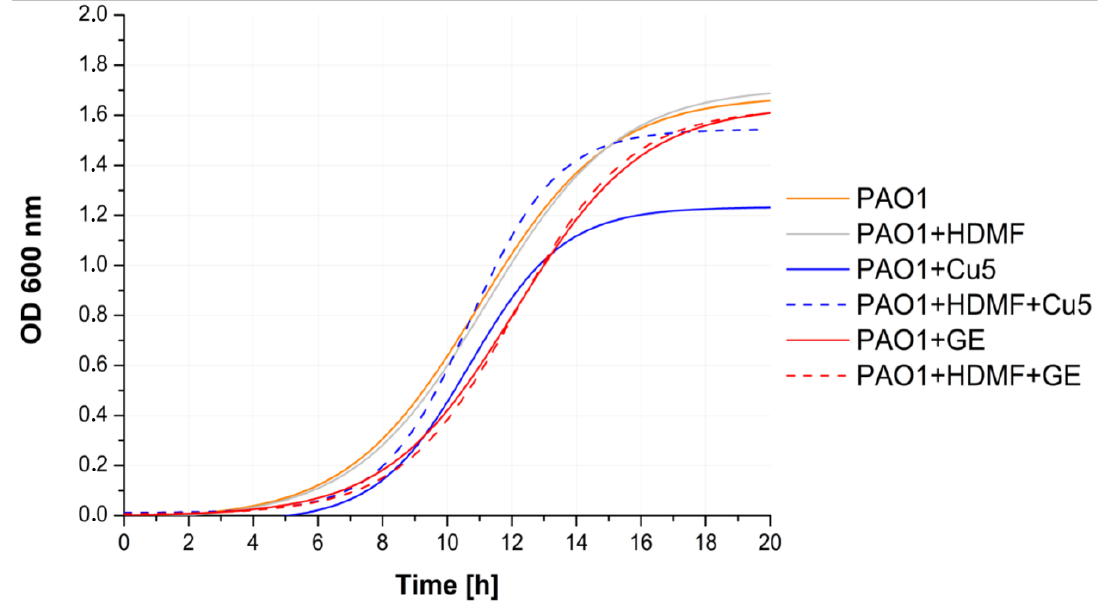
Figure 2. The impact of tested chemicals and their combination on the P. aeruginosa PAO1 growth kinetics. Fitted curves were established on the average of triplicate OD 600 measurement and the SD in the range +/ − 0 – 0.3. The kinetics were measured at 20 min intervals).